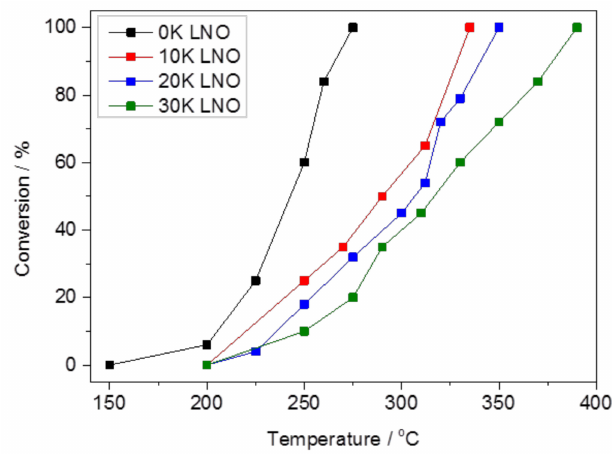
Figure 5. CO 2 conversion as a function of temperature for the 0–30K LNO samples.